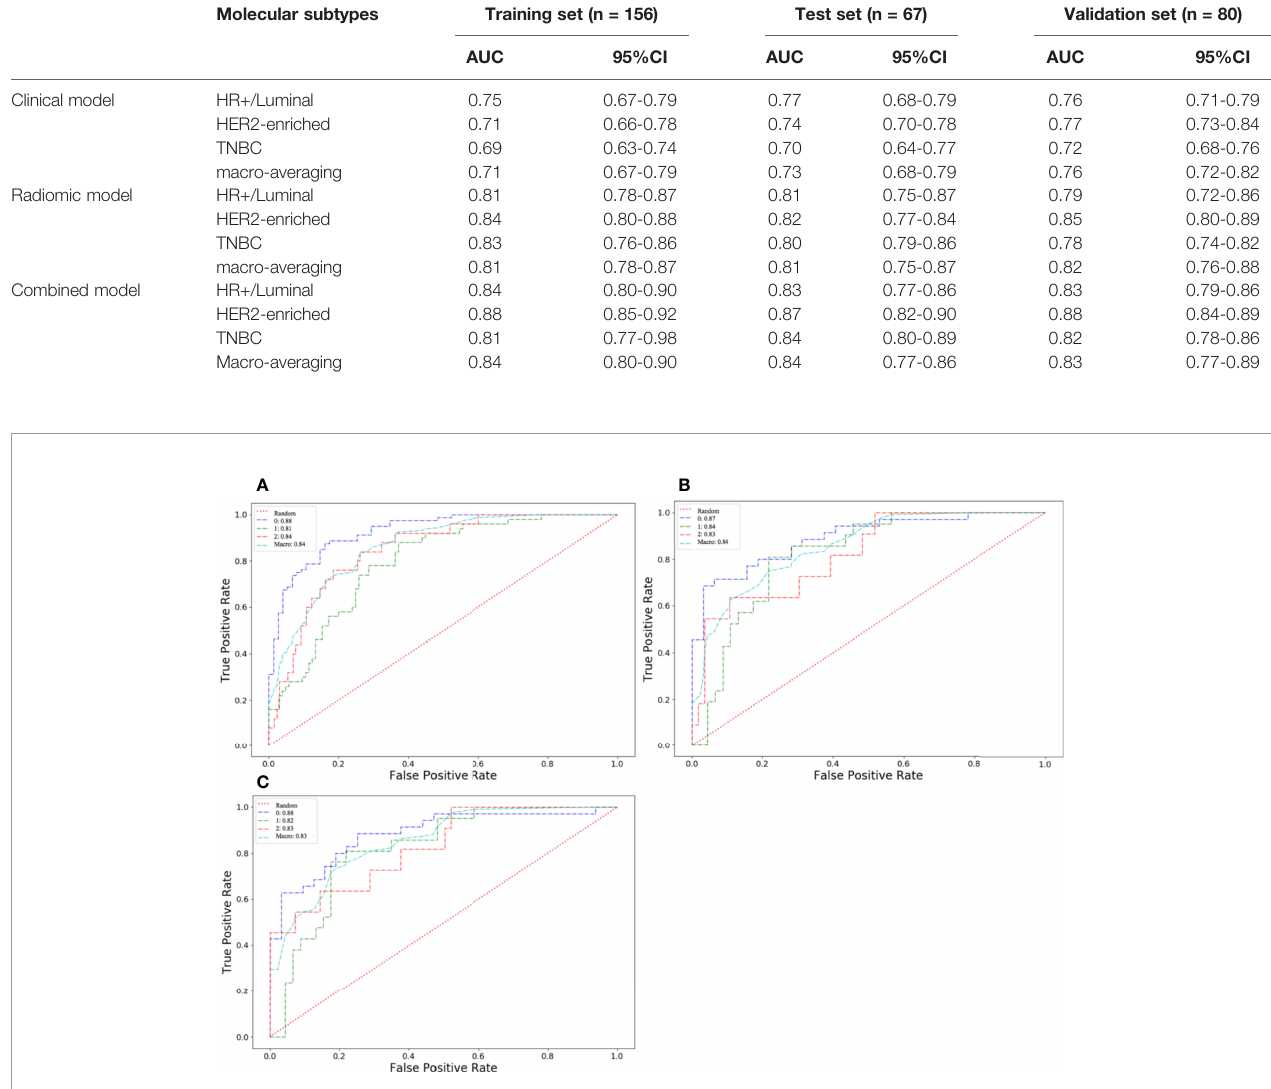
FIGURE 4 | Receiver operating characteristic (ROC) curves of the combined model in distinguishing molecular subtypes of breast cancer. (A) The training set. (B) The test set. (C) The external validation set.